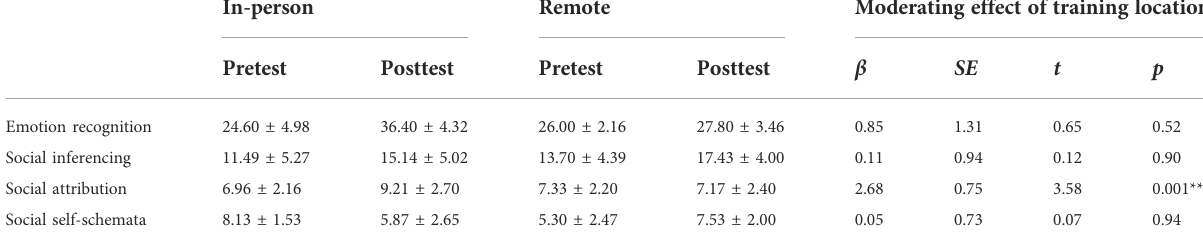
TABLE 4 Comparison if in-person vs remote training outcomes on four measures of social cognition.